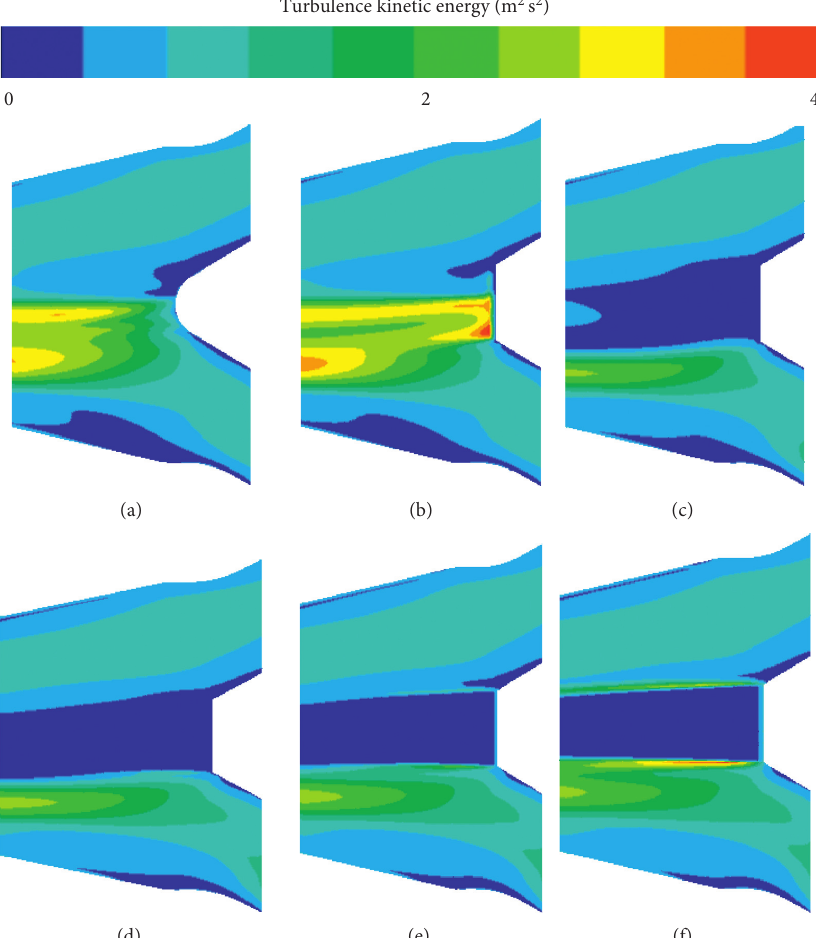
Figure 17: Cloud diagram of turbulent kinetic energy distribution in the longitudinal section of the nozzle section. (a) Original device, (b) v � 0, (c) v � 4, (d) v � 8, (e) v � 12, (f) v � 16 (m s − 1 ). jet jet jet jet jet